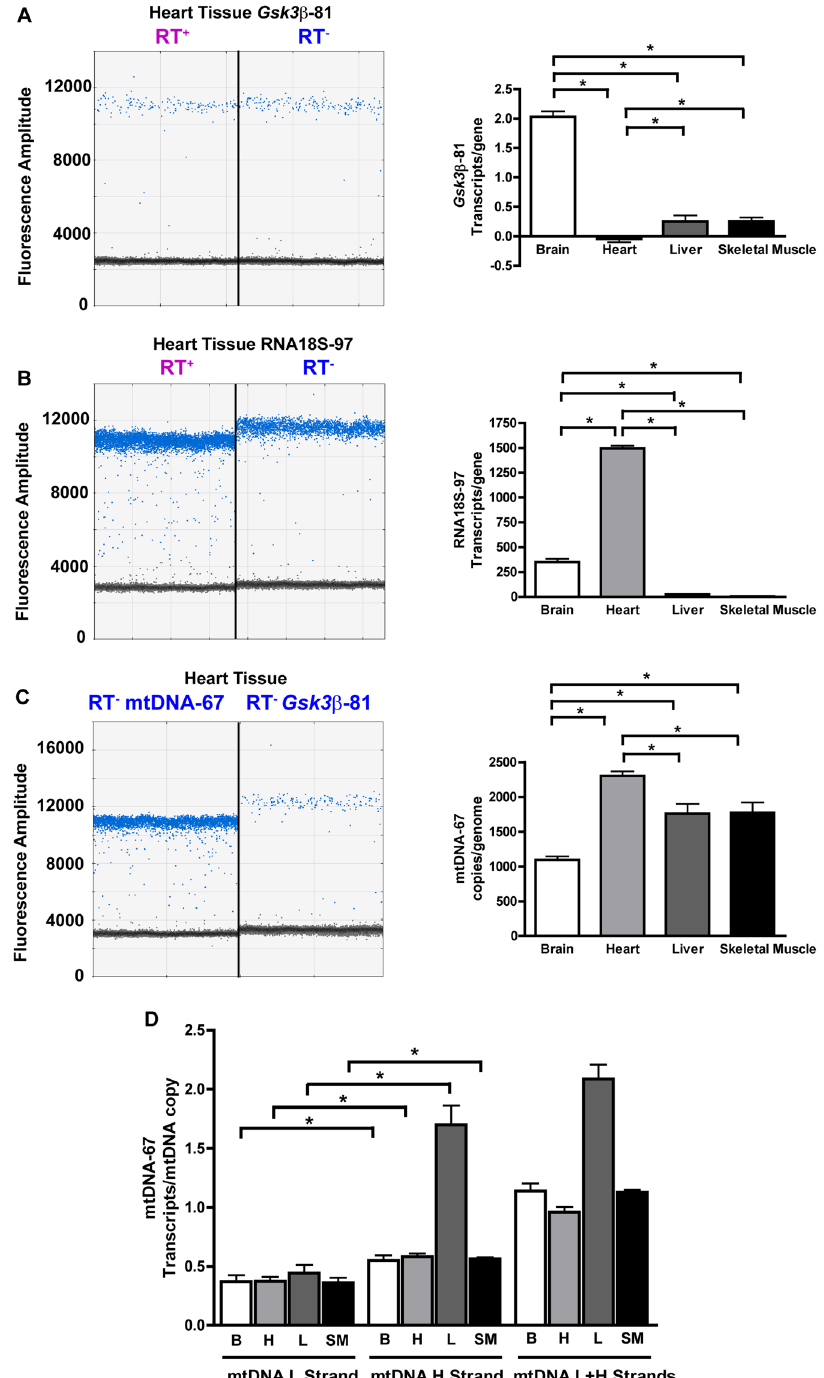
Figure 4. Absolute measurement of gene transcription in different tissues with Selfie-dPCR. The numbers of transcripts per gene were measured for single-copy and multiple-copy nuclear genes and in mitochondrial DNA in different tissues. ( A ) Quantitative analysis of the numbers of transcripts per gene of the single-copy nuclear gene GSK3 β in different tissues. Left: representative scatter plot of dPCR in a sample from heart tissue. In heart tissue, there were no significant differences between the RT + and RT − reactions, thus illustrating the lack of detectable Gsk3 β transcription. ( B ) Quantitative analysis of the numbers of transcripts per gene of the multiple- copy nuclear gene RNA18S in different tissues. Left: representative scatter plot of dPCR in a sample from heart tissue. ( C ) Graph showing the numbers of copies of mtDNA per genome in different tissues. Left: representative scatter plot of dPCR in a heart sample showing amplification of the mtDNA-67 to calculate mtDNA copy number in the left panel and Gsk3 β -81 to calculate the number of genome copies in the right panel. ( D ) Strand- specific analysis of transcription of mitochondrial Heavy (H) and Light (L) strands measured separately and simultaneously in brain (B), heart (H), liver (L) and skeletal muscle (SM). * Significantly different, p <